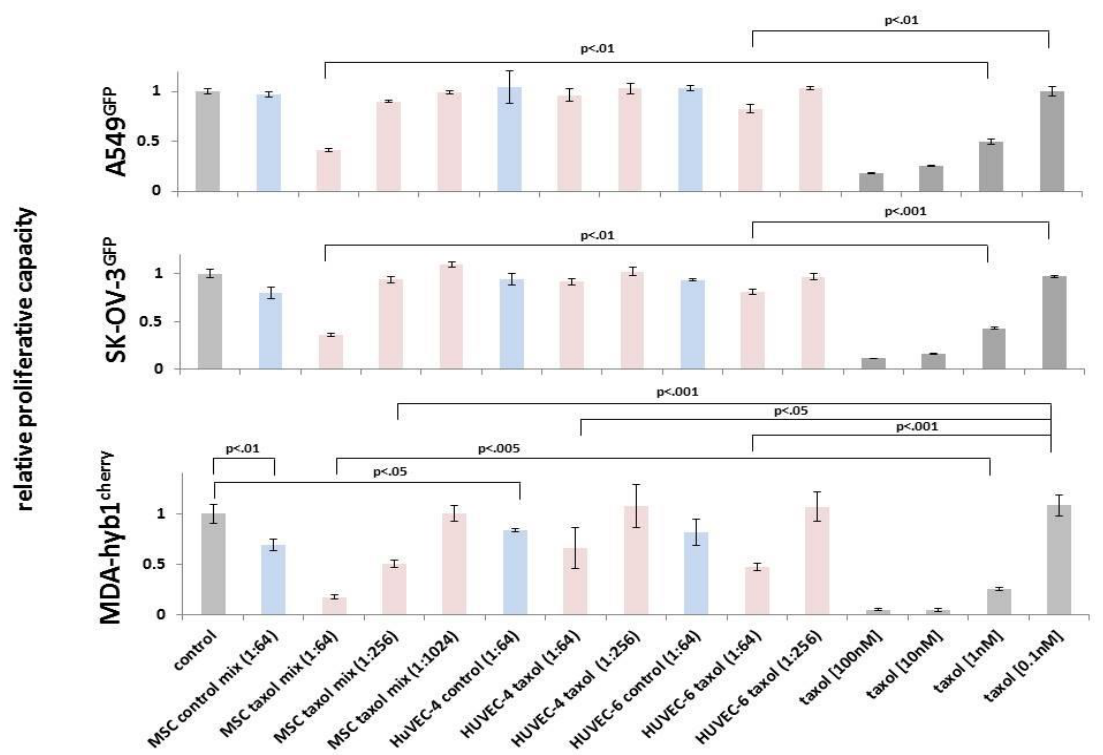
Figure 5. In vitro cytotoxicity of different human cancer cell lines including A549 lung cancer (upper panel), SK-OV-3 ovarian cancer (middle panel), and MDA-hyb1 breast cancer (lower panel) was measured by GFP fluoroscan assay. The different cancer cell populations were treated with appropriate dilutions of control exosomes from MSC and HuVECs as indicated (light blue bars), taxol-loaded exosomes from MSC and HuVECs as indicated (light red bars), and taxol substance (0.1 nM to 100 nM, dark grey bars) for 72 h, respectively. Fluorescence values of untreated steady state control cells (control, light gray bars) were set to 1, and relative cytotoxic effects were calculated as part of the control. Data represent the mean + s.d. ( n ≥ 3), and significance ( p ) was calculated by an unpaired two-tailed Student’s t -test.